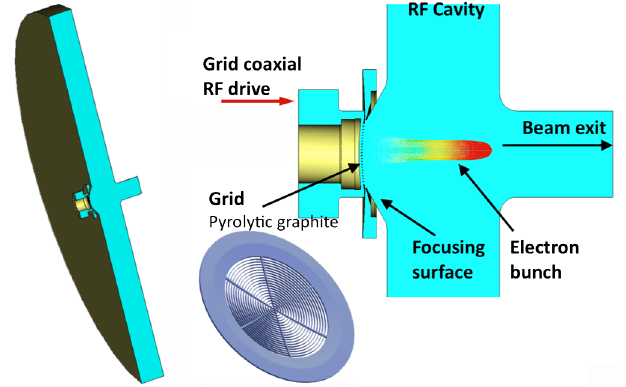
FIG. 16. (Left) Cut-away view of the schematic of a 700 MHz rf-gated thermionic electron gun integrated into a cylindrical rf accelerating cavity. The power port is not shown. (Right) Close- up view of the central region of the cavity, showing the cathode and the holeless grid (inset), and the transit of a electron bunch. FIG. 17. Beginning stages of bunch